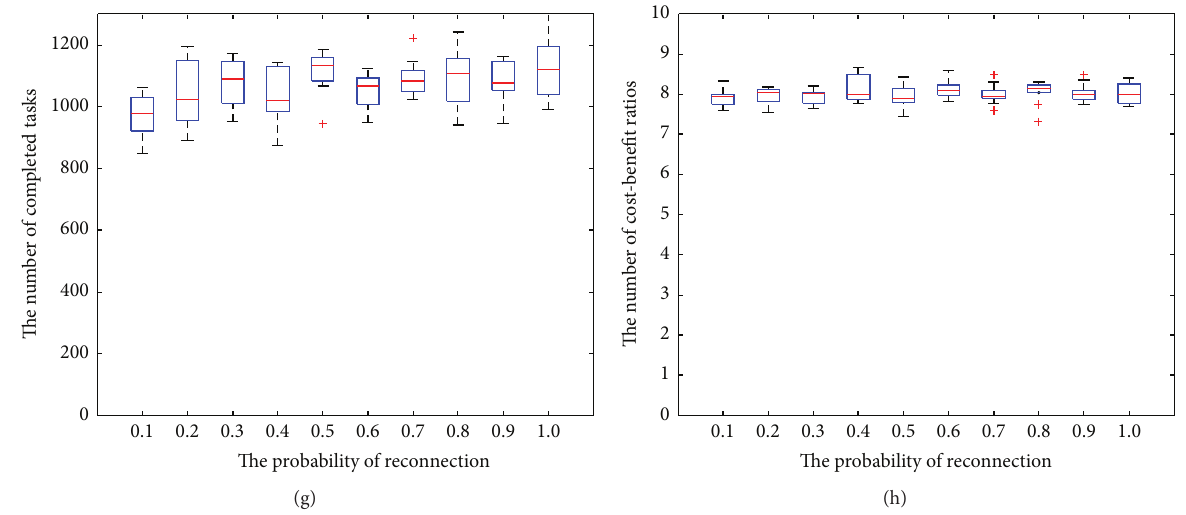
Figure 12: Simulation results of organizational performance with different (a)-(b) recruit probability, (c)-(d) resource probability, (e)-(f) arrest probability, and (g)-(h) reconnection probability.